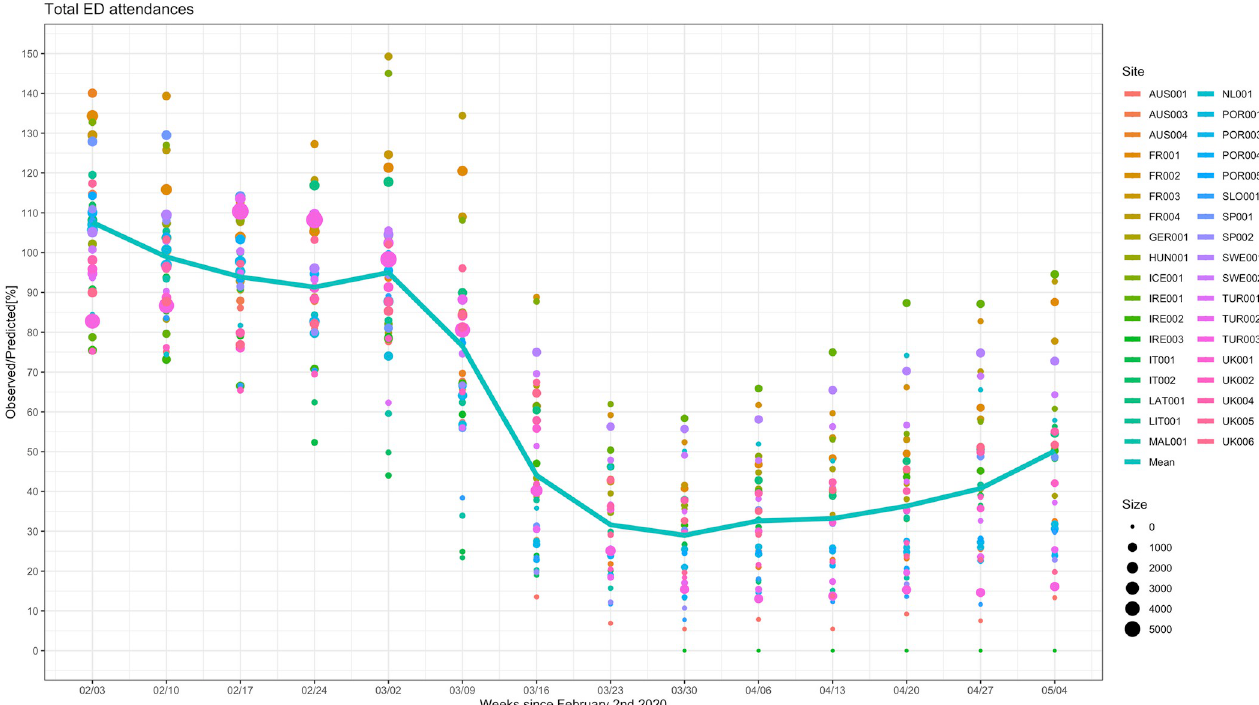
Fig 3. Observed versus predicted hospital admissions for patients attending the ED (%). The observed versus predicted number of children admitted to hospital from the ED in countries across Europe in the weeks following February 2, 2020 until May 11, 2020, for all sites combined. The color and the size of the dots reflect the actual number of ED attendances for each site and for each time window. The line connects the mean of the observed vs. predicted point estimates for each of the individual sites for each time window.